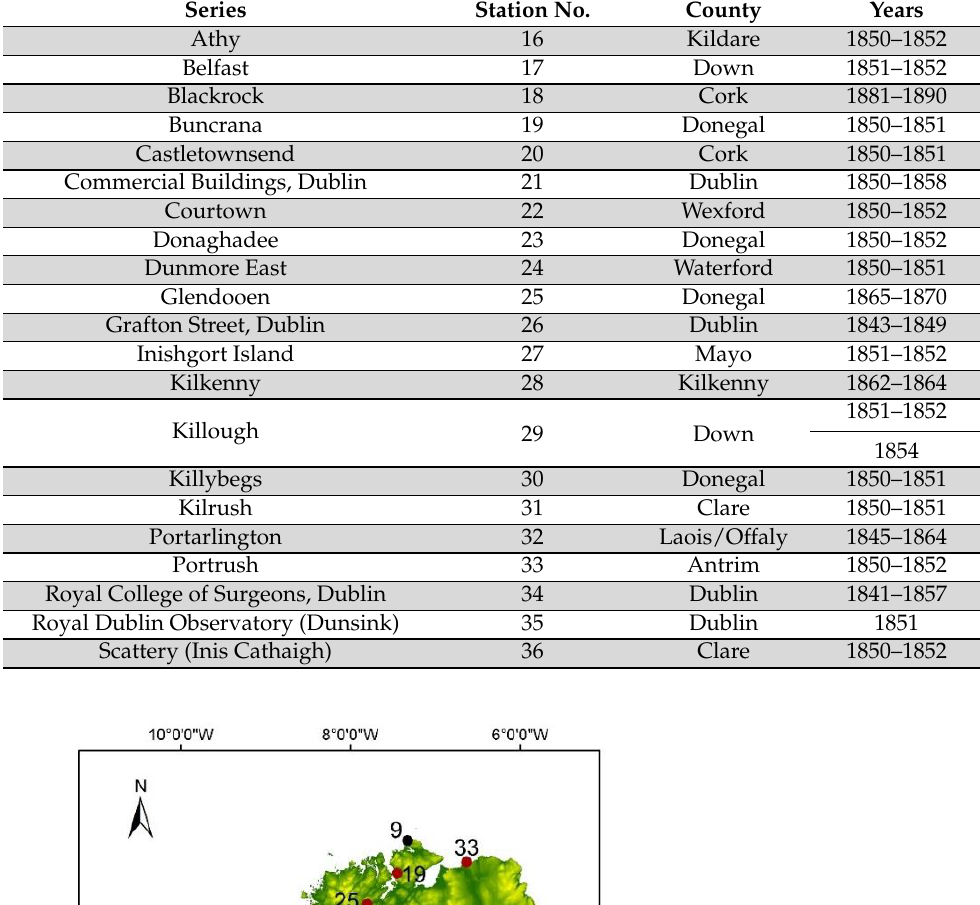
Table 2. Historical quality-controlled short-term daily MAX and MIN series.